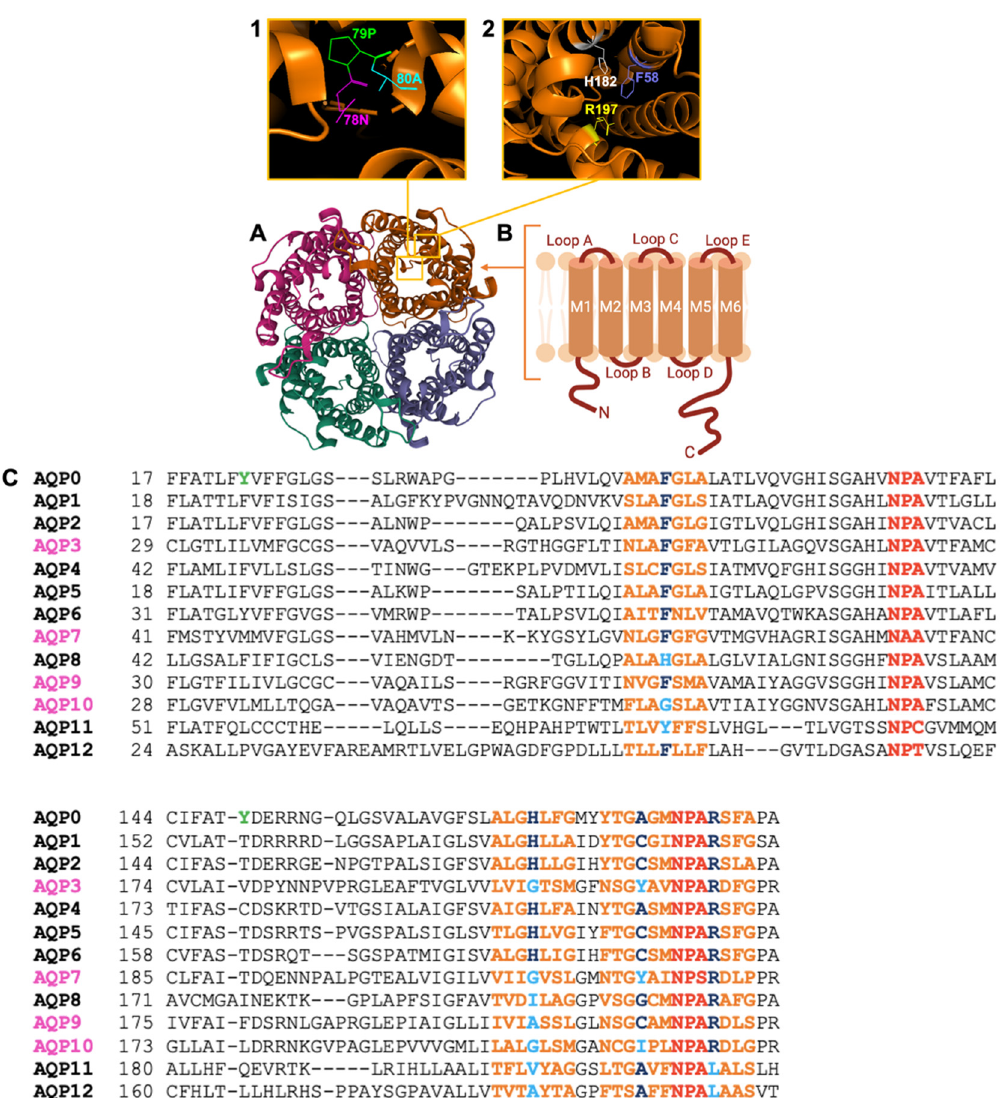
Figure 2. Schematic representation of the Aquaporin-1 channel structure . ( A ) The extracellular face of tetrameric AQP1, from the X-ray crystal structure for bovine AQP1 (Protein Data Bank 1J4N). ( B ) Simplified transmembrane topography diagram of an individual subunit showing six helical transmembrane domains (M1–M6) connected by loops A–E. ( Inset 1 ) View of Pro 79, Asp 80 and Asn 78 residues in the signature NPA motif. ( Inset 2 ) View of His 182, Phe 58 and Arg 197 residues in the ar/R constriction enabling selective water permeability. ( C ) Partial amino acid sequence alignment of human AQPs 0–12 comparing the NPA motifs (red) and ar/R constriction regions (orange). Aquaglyceroporins are shown in magenta. Conserved residues within the ar/R constrictions are highlighted in navy; deviations from this are highlighted in cyan. The Tyr phenolic barrier specific to AQP0 is shown in green. Panels A and B are adapted from Varricchio et al. [76]. In each monomer, the amphipathic pore connecting the intracellular and extracellular vestibules consists of hydrophilic α -carbonyl groups from the polypeptide backbone, and hydrophobic residues [77]. Asparagine side chains in the NPA motifs oriented into the pore act as hydrogen-bond donors and acceptors to coordinate single-file water transport through the pore, whereas positively charged residues repel proton passage [78]. A narrow region in the extracellular vestibule featuring aromatic (ar) and arginine (R) residues is termed the ar/R constriction (inset 2, top row), which provides substrate selectivity by size exclusion based on the limiting diameter [79]. The partial sequence alignment of